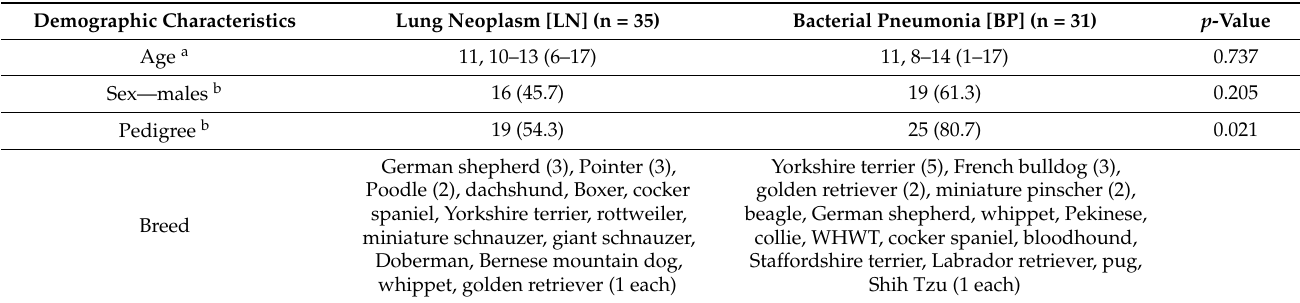
Table 1. Demographic characteristic of the study population.